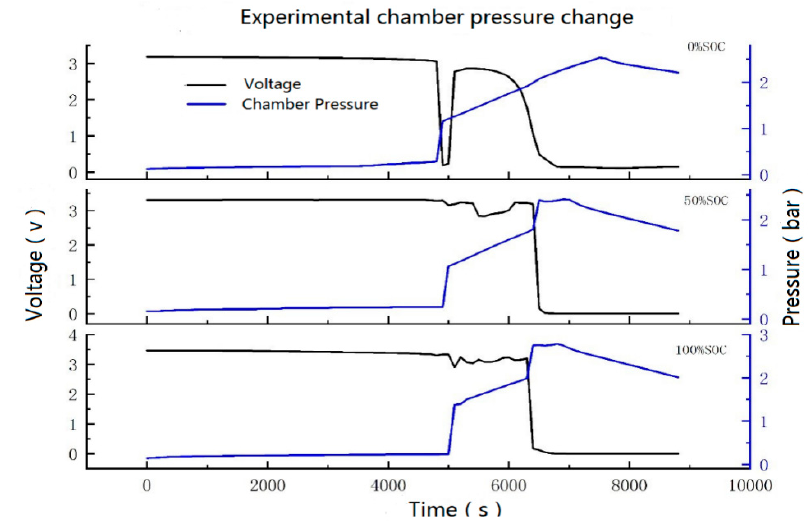
Figure 9. Pressure change curve of experimental chamber, showing two stages of eruption. At 0% SOC, the battery valve was opened and there was no major secondary eruption. A second eruption occurred at 50% and 100% SOC, and the manifested traits are largely constant.